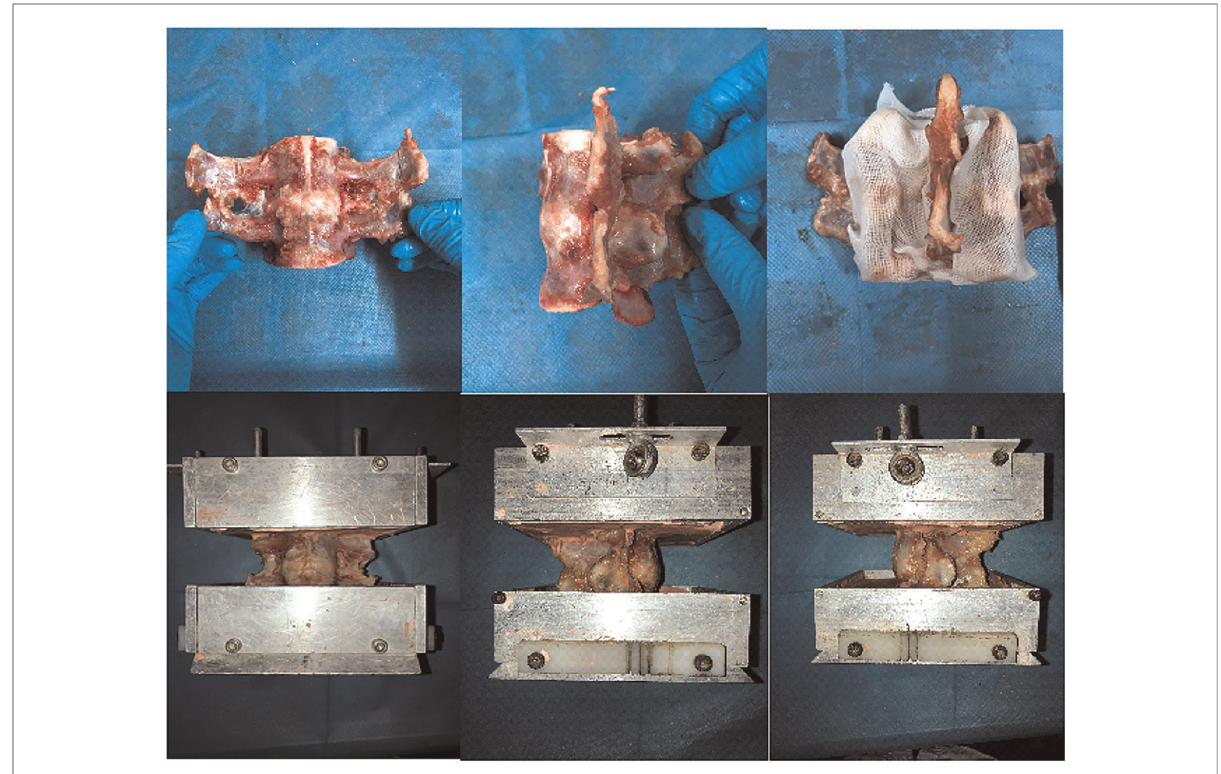
FIGURE 1 Specimen pretreatment and